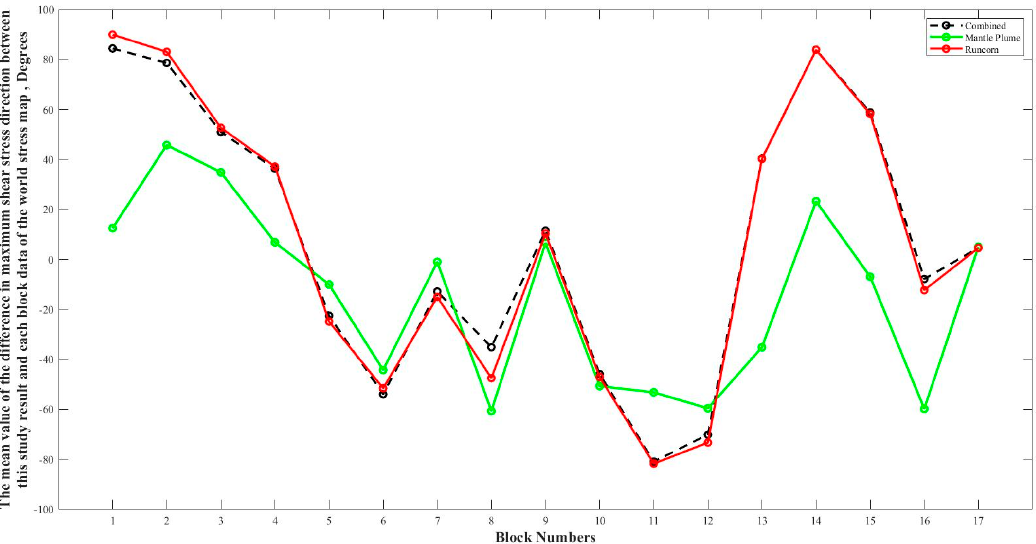
Figure 11. The mean values of the differences between our maximum shear stresses and those of WSM2008 data in the selected regions.